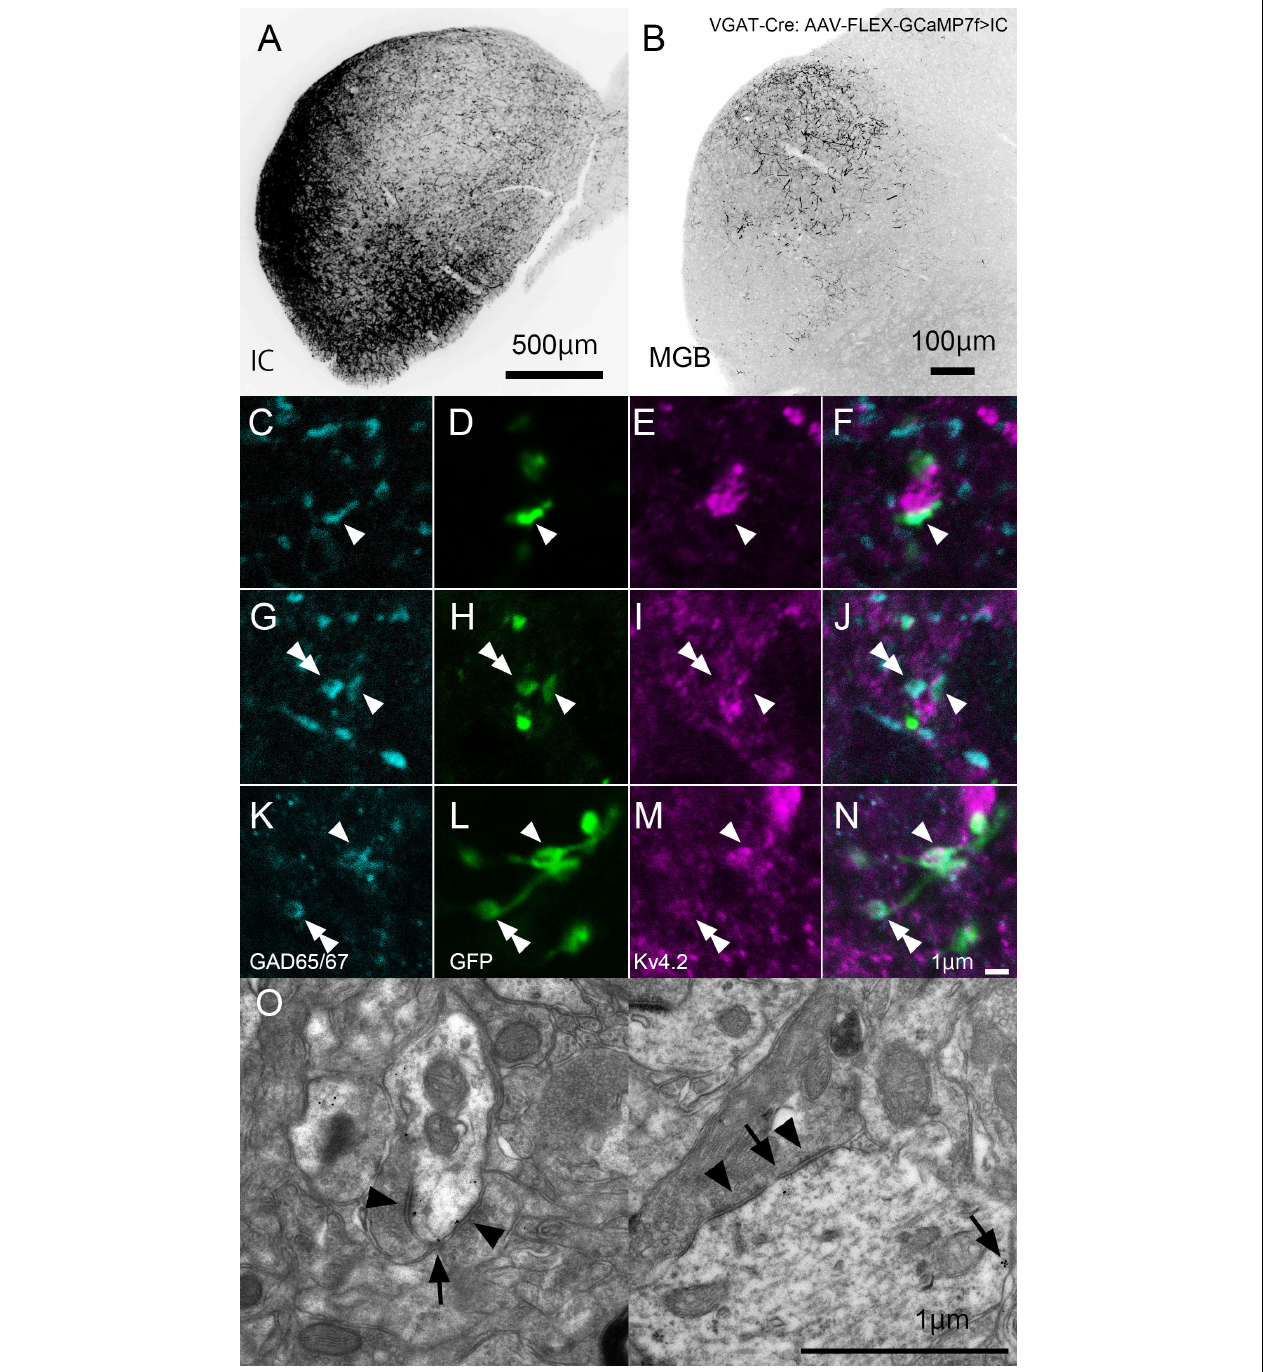
FIGURE 8 | Formation of synapses between Kv4.2-positive postsynaptic MGV microregions and inhibitory terminals from IC. (A) An example of a GFP-immunostained coronal section of IC, showing the injection center. (B) GFP-positive axonal plexuses in the MGB. (C–N) Triple fluorescence for glutamic acid decarboxylase 65/67 (GAD65/67, cyan; C,G,K ), GFP (green; D,H,L ), and Kv4.2 (magenta; E,I,M ) in the MGV of VGAT-Cre mice. Arrowhead: GAD65/67 positive terminal that is in the contact with Kv4.2-positive structure and double arrowhead: GAD65/67 positive terminal that does not make a contact with Kv4.2 positive structure. (E,J,N) Images are acquired from different sections. (O) Examples of symmetric inhibitory synapses in the MGV using pre-embedding immunoelectron microscopy. Arrow: Kv4.2 (gold colloid) and arrowhead: symmetrical synapse that is in contact with Kv4.2-positive postsynaptic structure. Scale bar: 500 µ m (A) , 100 µ m (B) , and 1 µ m (C–O) . GFP, green fluorescent protein; IC, inferior colliculus; Kv4, Shal-related subfamily of potassium voltage-gated channel; MGB, medial geniculate body; MGV, ventral medial geniculate; VGAT, vesicular gamma-amino butyric acid transporter.